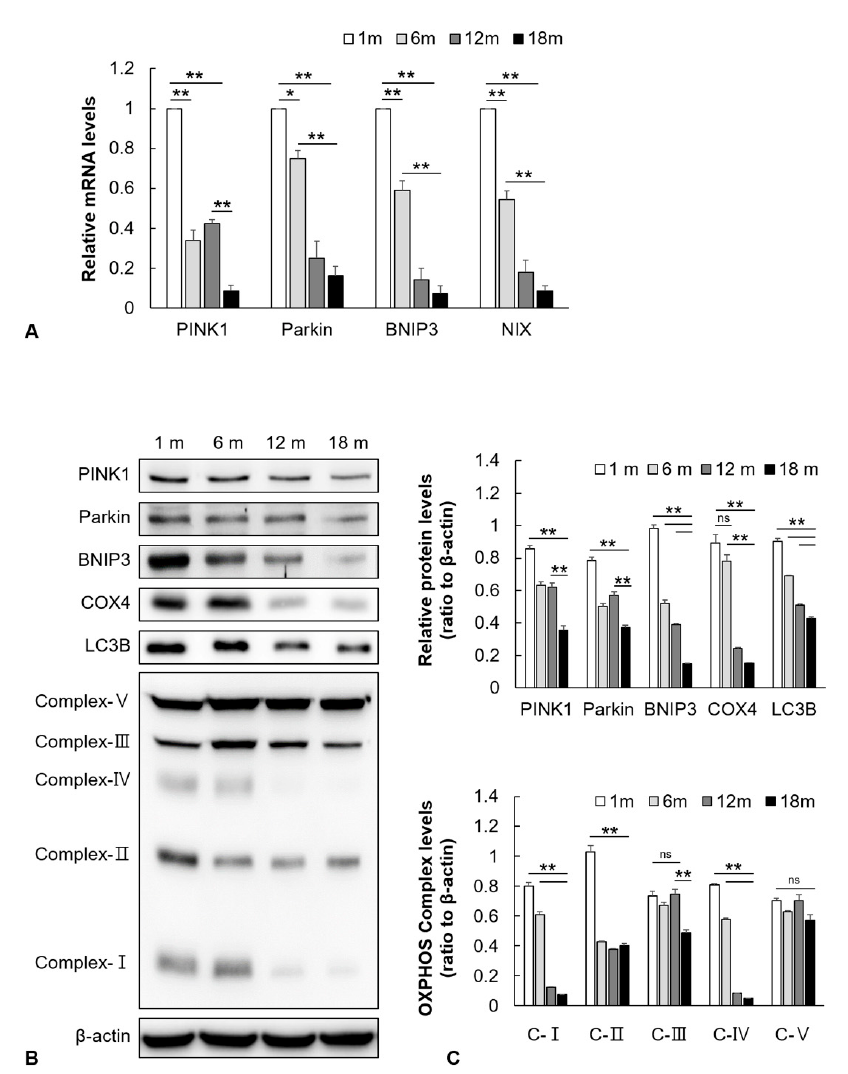
Figure 2. The effect of aging on the expression of mitophagy-related genes, proteins, and oxidative phosphorylation (OXPHOS) subunits in the mouse auditory cortex. ( A ) The mRNA expression levels of PINK1 , Parkin , BNIP3 , and NIX in the mouse auditory cortex significantly decreased with aging. ( B ) The Western blotting analysis of PINK1 , Parkin , BNIP3 , COX4 , LC3B, and OXPHOS subunits. β -actin was used as the loading control. ( C ) The relative protein expression levels of PINK1 , Parkin , BNIP3 , COX4 , LC3B, and OXPHOS subunits I–IV in the mouse auditory cortex significantly decreased with aging. The data are shown as mean ± standard error of mean (five mice per group; 1 m, 1 month; 6 m, 6 months; 12 m, 12 months; 18 m, 18 months). * p < 0.05, ** p < 0.01, ns: not significant.